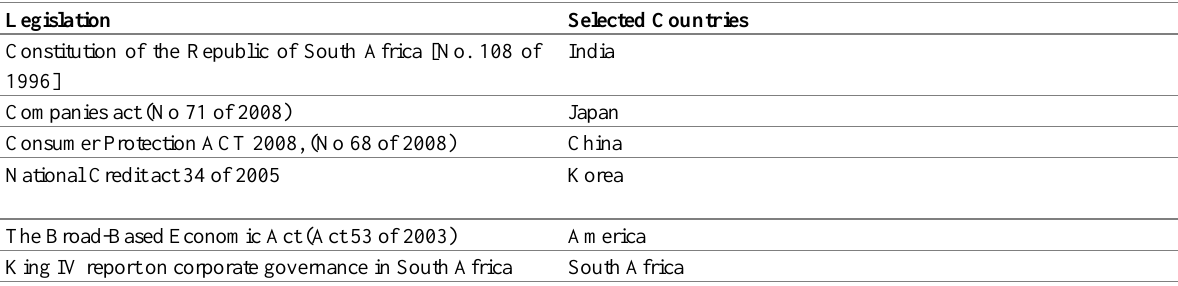
Table 1: Sample of the